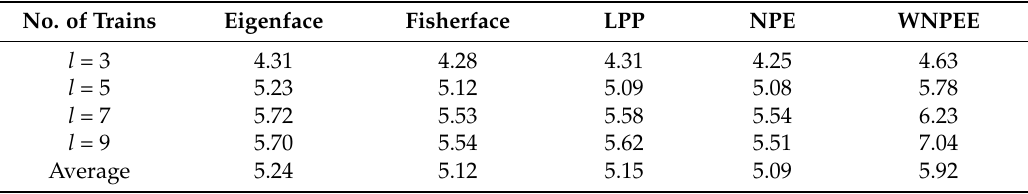
Table 3. Computation time on GT face database under different trains for one run (time in seconds).